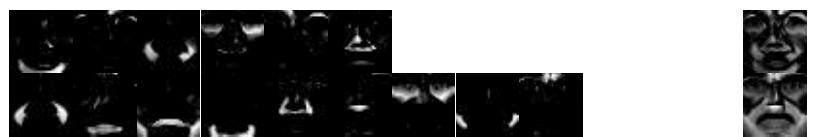
Figure 11. The left side parts are final extracted features t achieved by the proposed method. The right side image is achieved by adding the values of the left side. Top images are related to JAFFE and bottom images to MUG dataset.